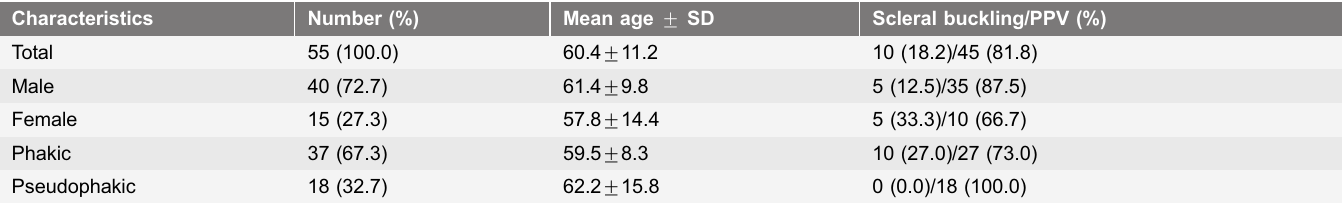
Table 1. Preoperative patient characteristics, lens status, and type of surgery. Characteristics